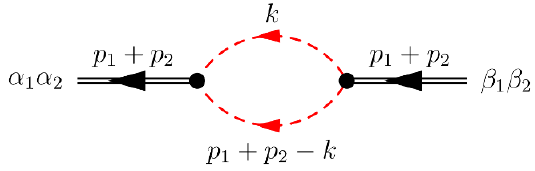
Figure 5 . Feynman diagram for two-point function h 0 j ~ T (cid:11) 1 (cid:11) 2 ( (cid:0) p 1 (cid:0) p 2 ) ~ T (cid:12) 1 (cid:12) 2 ( p 1 + p 2 ) j 0 i in the free scalar theory. Straight double lines are for the T operator and dashed singled lines for scalars. Red lines indicate Wightman